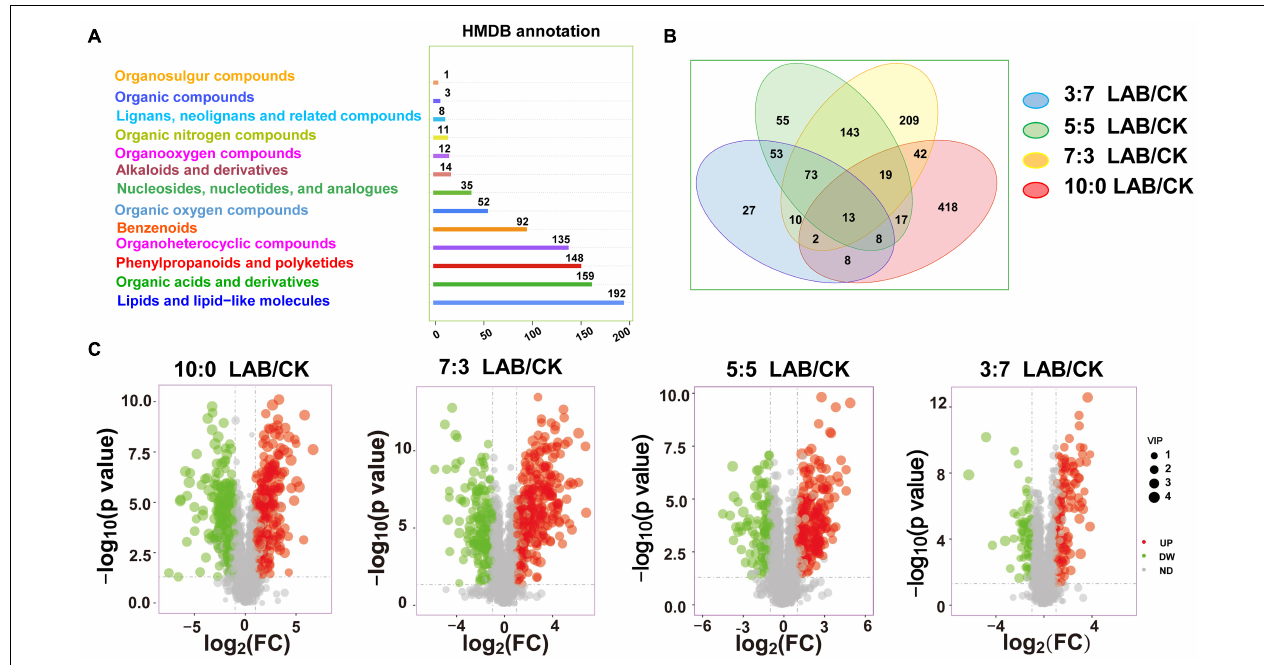
FIGURE 3 | The metabolome of SC-SS silage. (A) Classification annotation of metabolites in HMDB database. (B) Venn diagram depicting specific or common metabolites of SC-SS silage. (C) Volcano plot of the differentially expressed metabolites (LAB/CK). UP, upregulated metabolites; DW, downregulated metabolites; ND, no